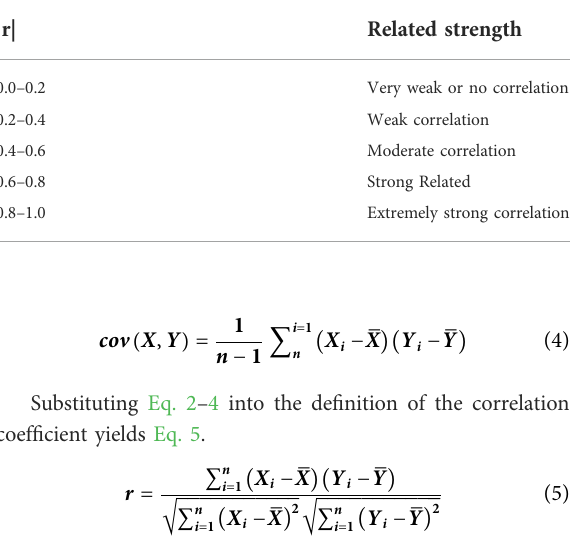
TABLE 1 Table of feature correlated